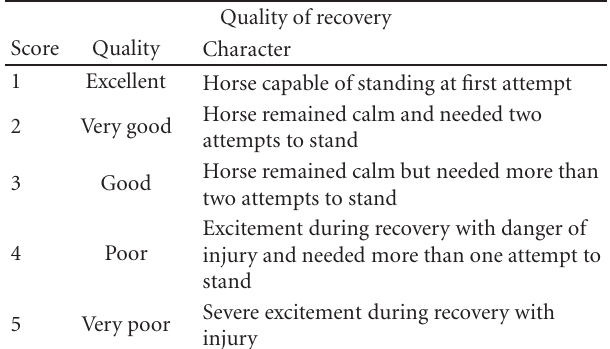
Table 3: Score card for quality of